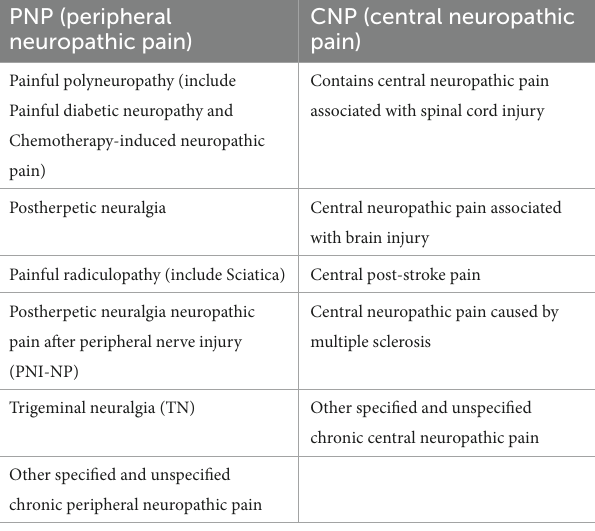
TABLE 1 Classification of chronic neuropathic pain in